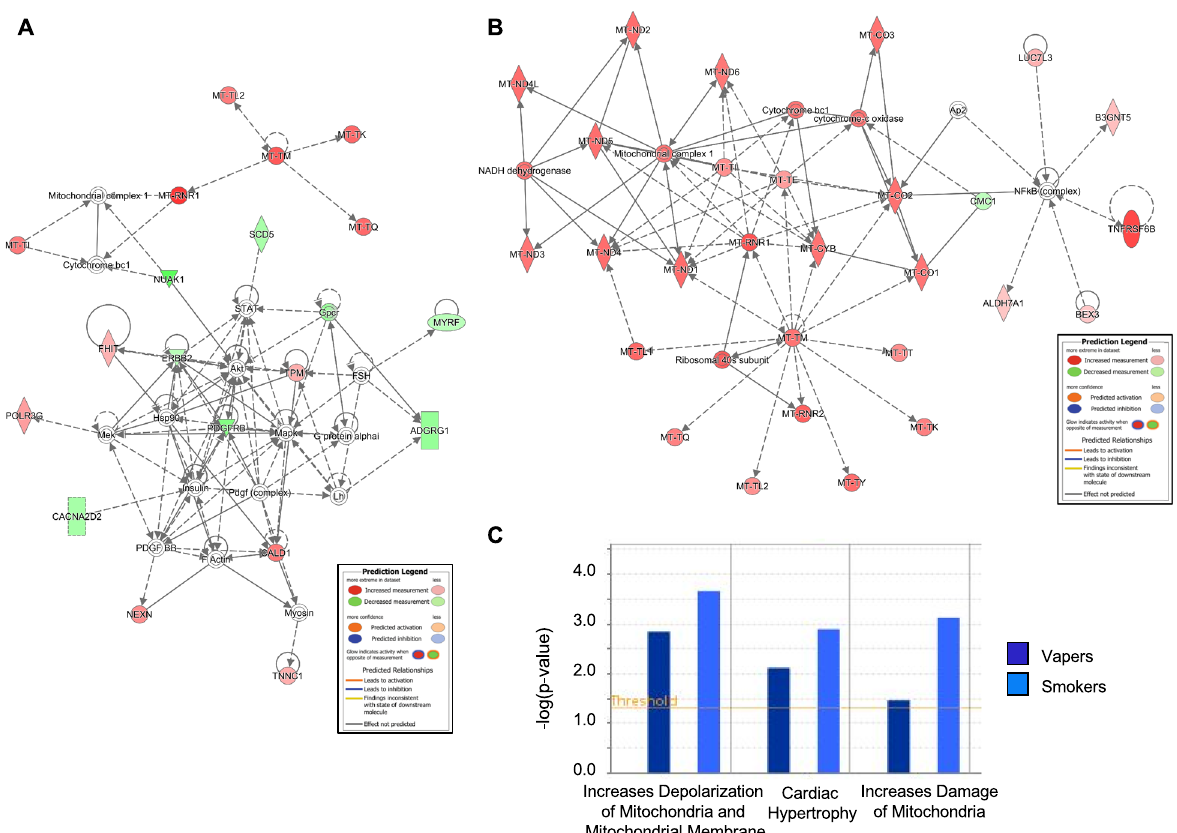
Figure 5. Gene networks and toxicity functions analysis of differentially expressed genes in vapers and smokers by IPA. The top functional networks impacted in (A) vapers and (B) smokers show high enrichment of mitochondrial genes. Red and green nodes represent up-regulated and down-regulated DEGs, respectively. White nodes show molecules that are not included in the datasets but interact with other components of the network. Solid line, direct interaction; dashed line, indirect interaction. (C) The IPA-Tox analysis tool was used to catalogue sets of molecules in the list of DEGs that were known to be involved in a particular type of toxicity or phenotype. Major toxic effects associated with DEGs in vapers (dark blue) and smokers (light blue) include increased depolarization of the mitochondrial membrane and damage of the